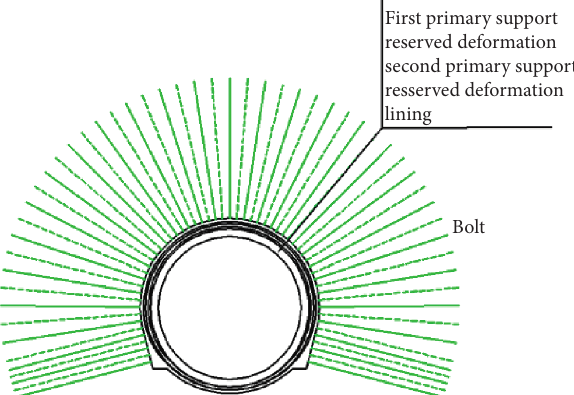
Figure 8: Large deformation support design of the Maoxian